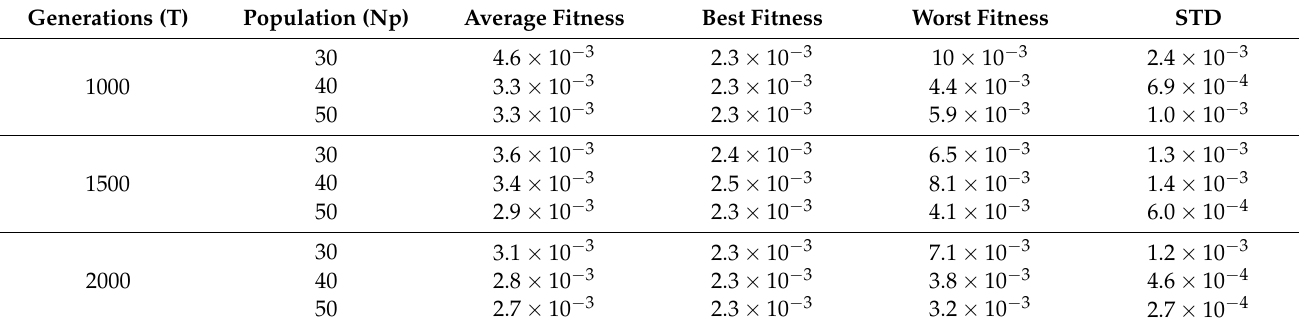
Table 13. AO analysis with respect to generation and population sizes at 0.06 noise variance.